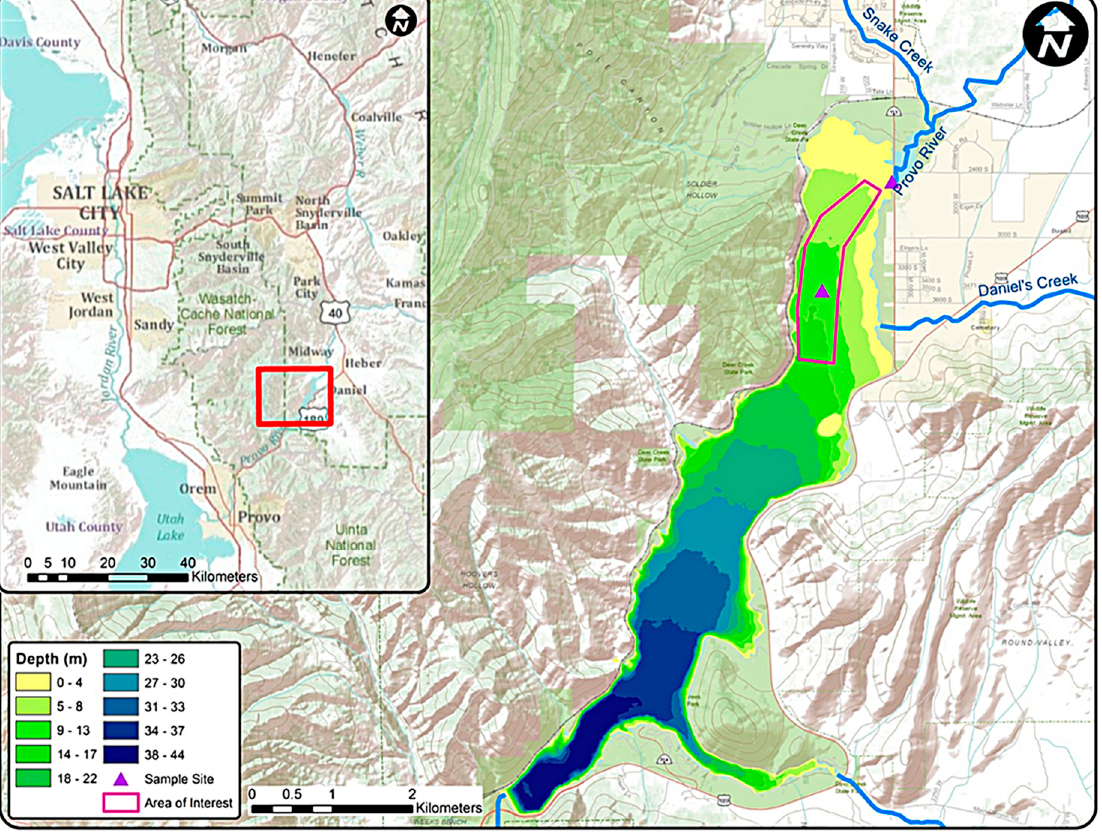
Figure 3. Deer Creek reservoir (DCR) with the study area, which is at the Provo River inlet, highlighted. The depths are relative to a full pool.